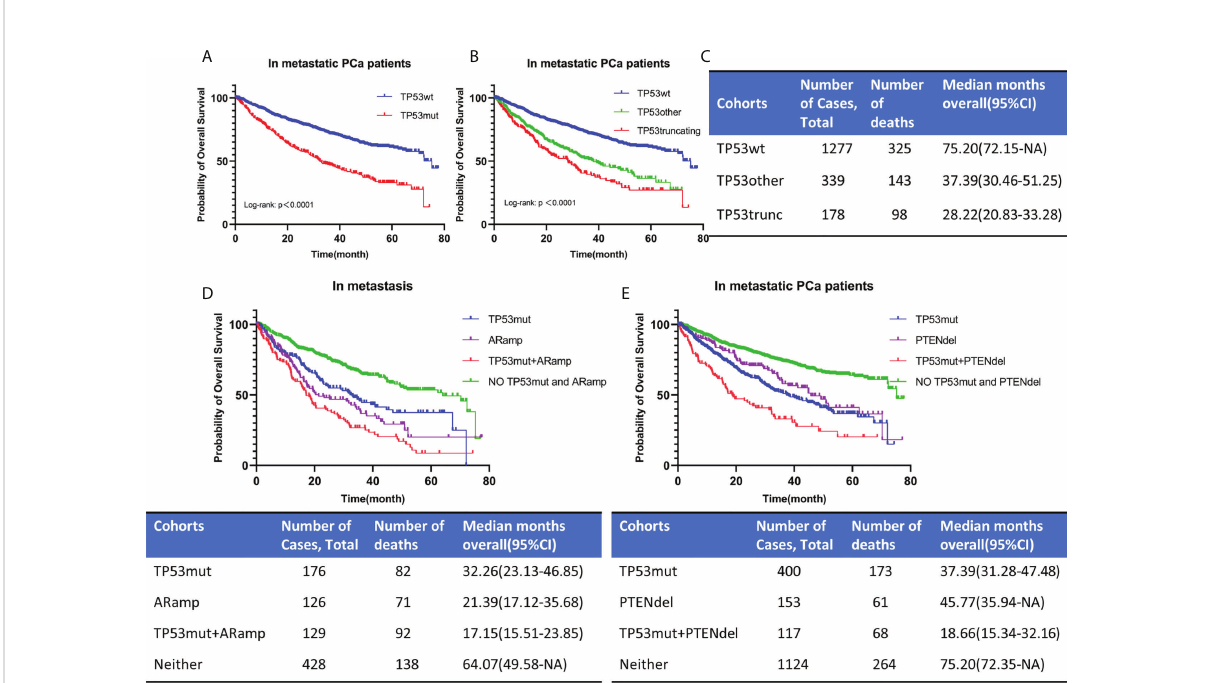
FIGURE 4 OS for metastatic PCa according to TP53 mutation status (A, B) . TP53 classi fi cation by means of mutational type (see the Methods section). The estimated median OS for different TP53 mutation status (C) . OS for metastatic PCa when AR ampli fi cation or PTEN deletion co-occurred with TP53 mutation (D, E) . TP53wt, TP53 wild type; TP53mut, TP53 mutation; ARamp, AR ampli fi cation; PTENdel, PTEN deletion; OS, overall survival; CI, con fi dence interval; NA, not